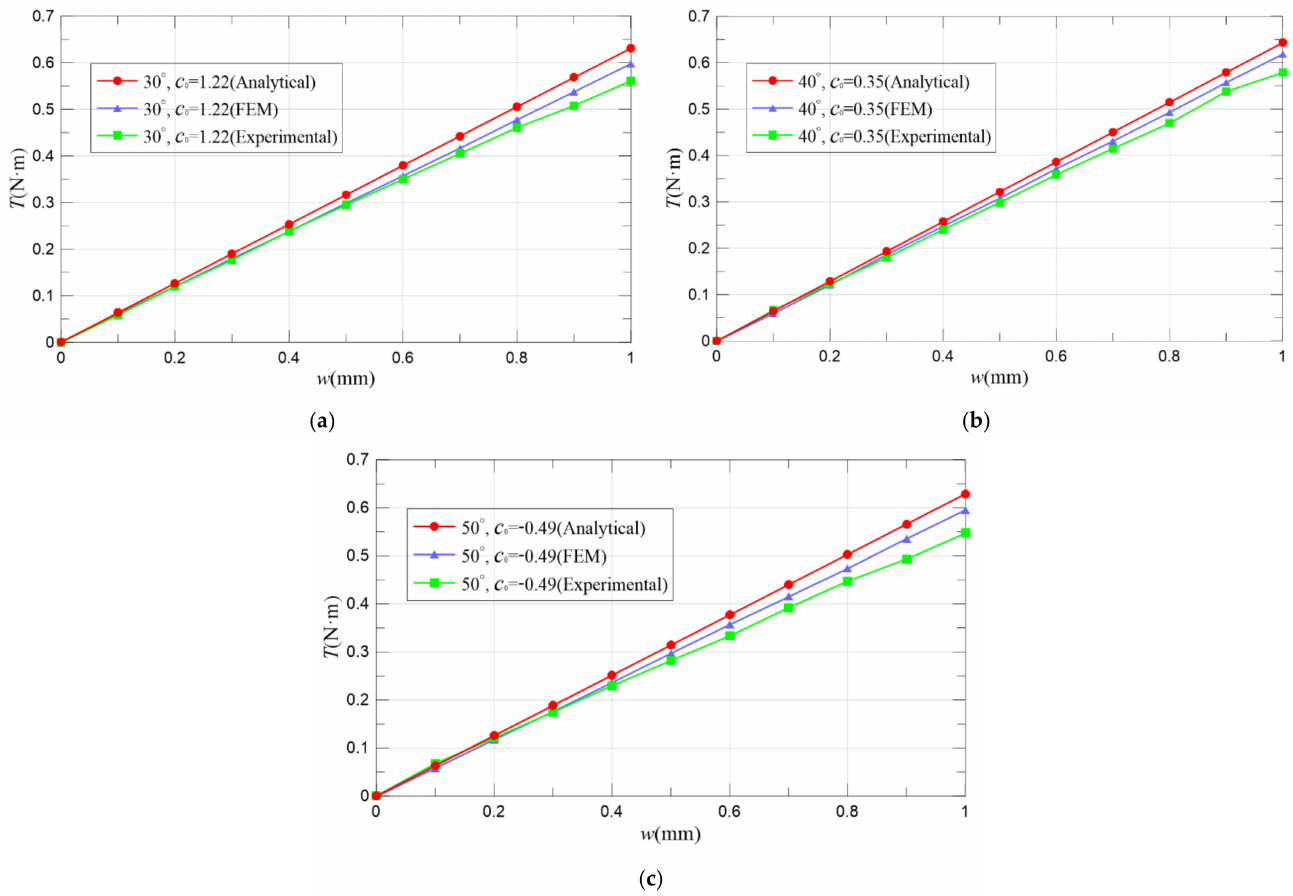
Figure 17. Torque–displacement characteristics of maglev coupling ( a ) α = 30 ◦ , c 0 = 1.22 mm; ( b ) α = 40 ◦ , c 0 = 0.35 mm; and ( c ) α = 50 ◦ , c 0 = − 0.49